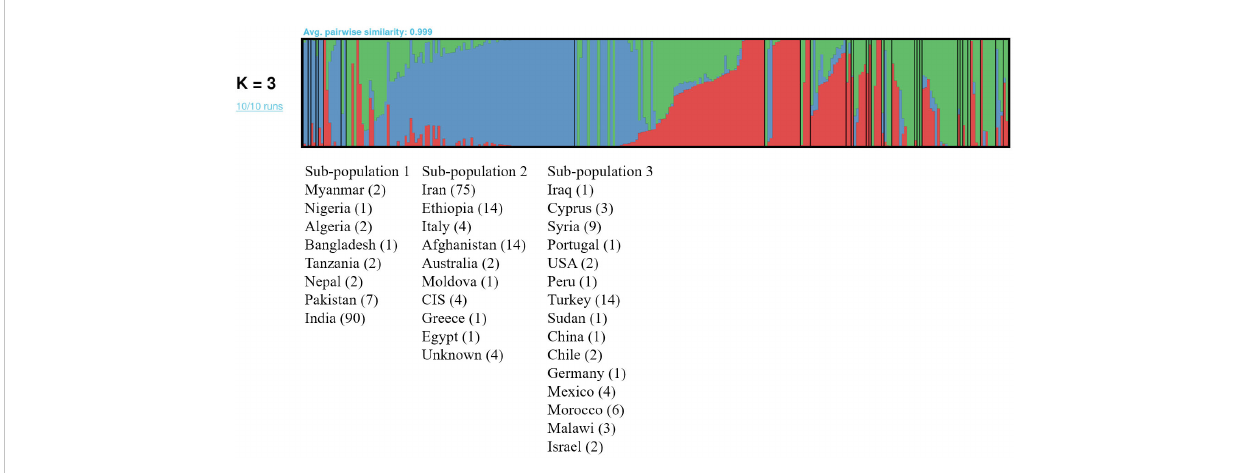
FIGURE 2 ADMIXTURE analysis of the chickpea association panel of 278 accessions using 112,998 SNPs and the pong tool formed 3 sub-populations: sub- population 1 (Blue), sub-population 2 (Red) and sub-population 3 (Green). The accessions in sub-populations were labelled as per country of origin, with the number of accessions in parentheses. The black vertical lines separate the countries within each sub-population. All the accessions in the respective sub-populations shared more than 50% ancestry except for accessions from Iraq, which had similar ancestry in all sub-populations and that of CIS and Iraq with ancestry between 40 to 50% for respective sub-populations.